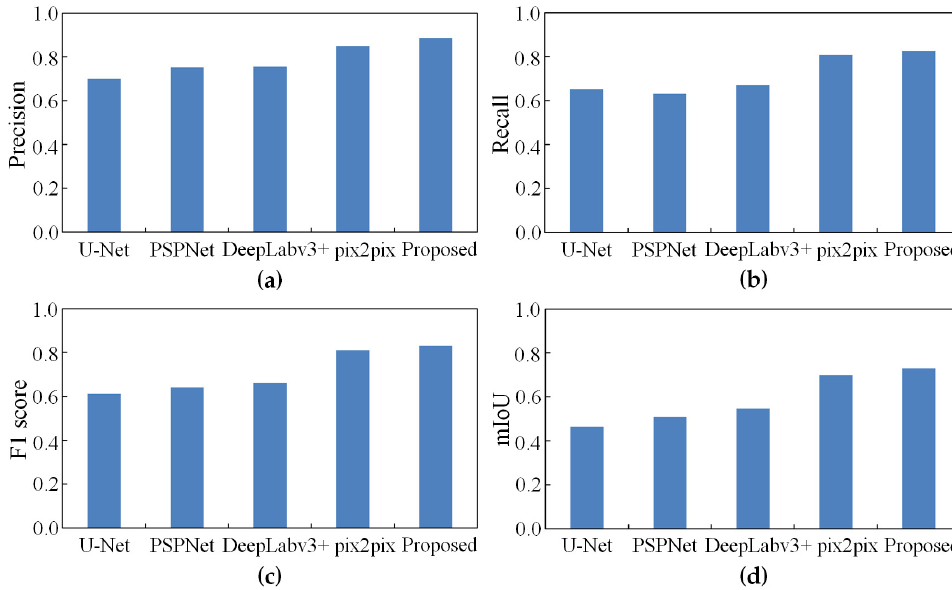
Figure 9. Comparisons of U-Net, PSPNet, DeepLabv3+, pix2pix, and the proposed method performed using the open-source dataset. ( a–d ) denote Precision , Recall , F 1 _score , and mIoU values of the five methods, respectively.